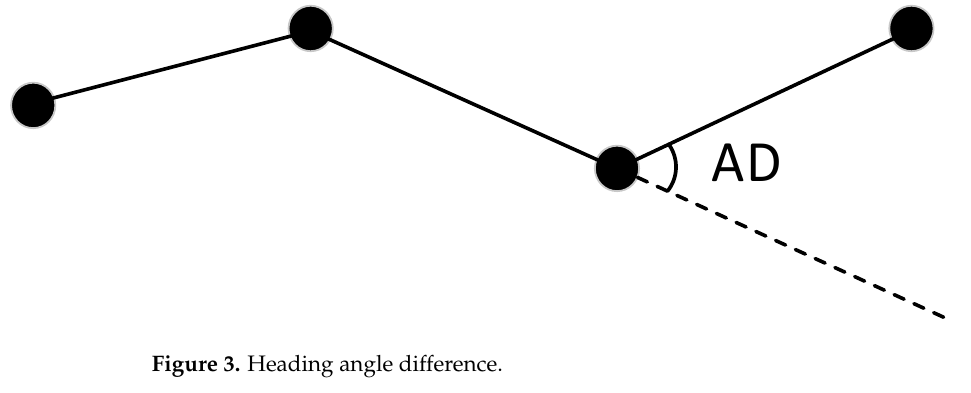
Figure 3. Heading angle difference.